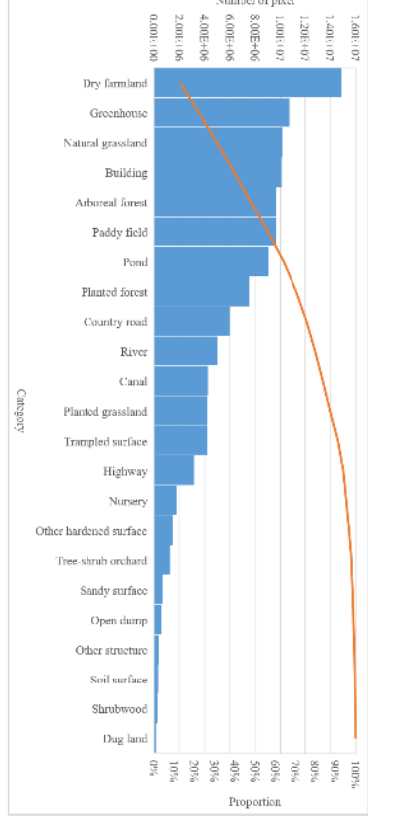
Figure 4 Samples after balancing processing